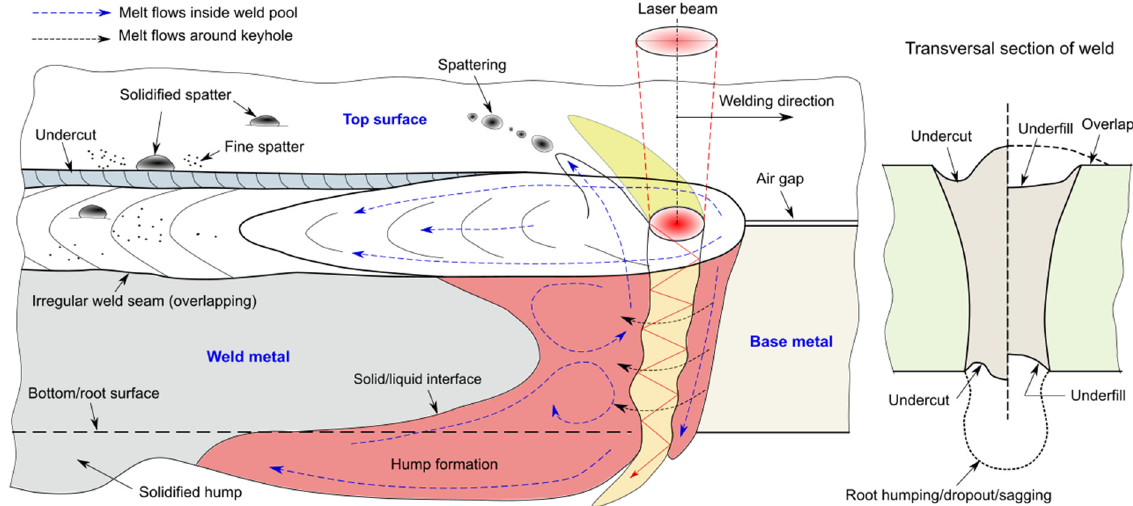
Figure 21. Schematic illustration of external imperfection in laser beam keyhole welding during full penetration. Based on [88,164,275,293–296].